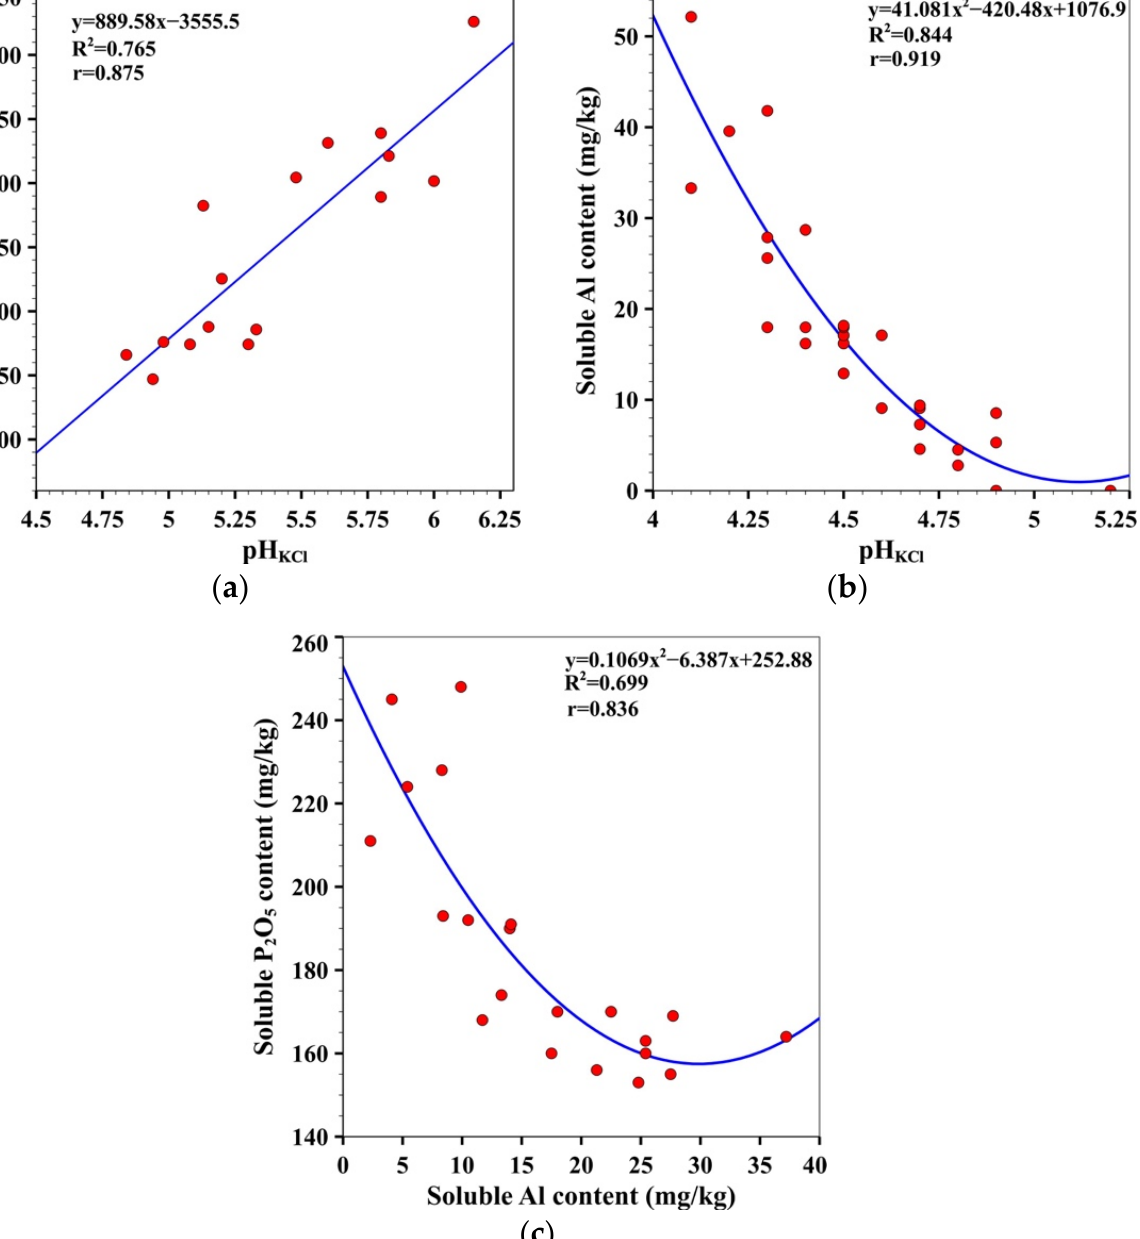
Figure 5. ( a ) Relationship between soluble Ca and pH KCl , ( b ) between soluble Al and pH KCl , and ( c ) between soluble P 2 O 5 and soluble Al.